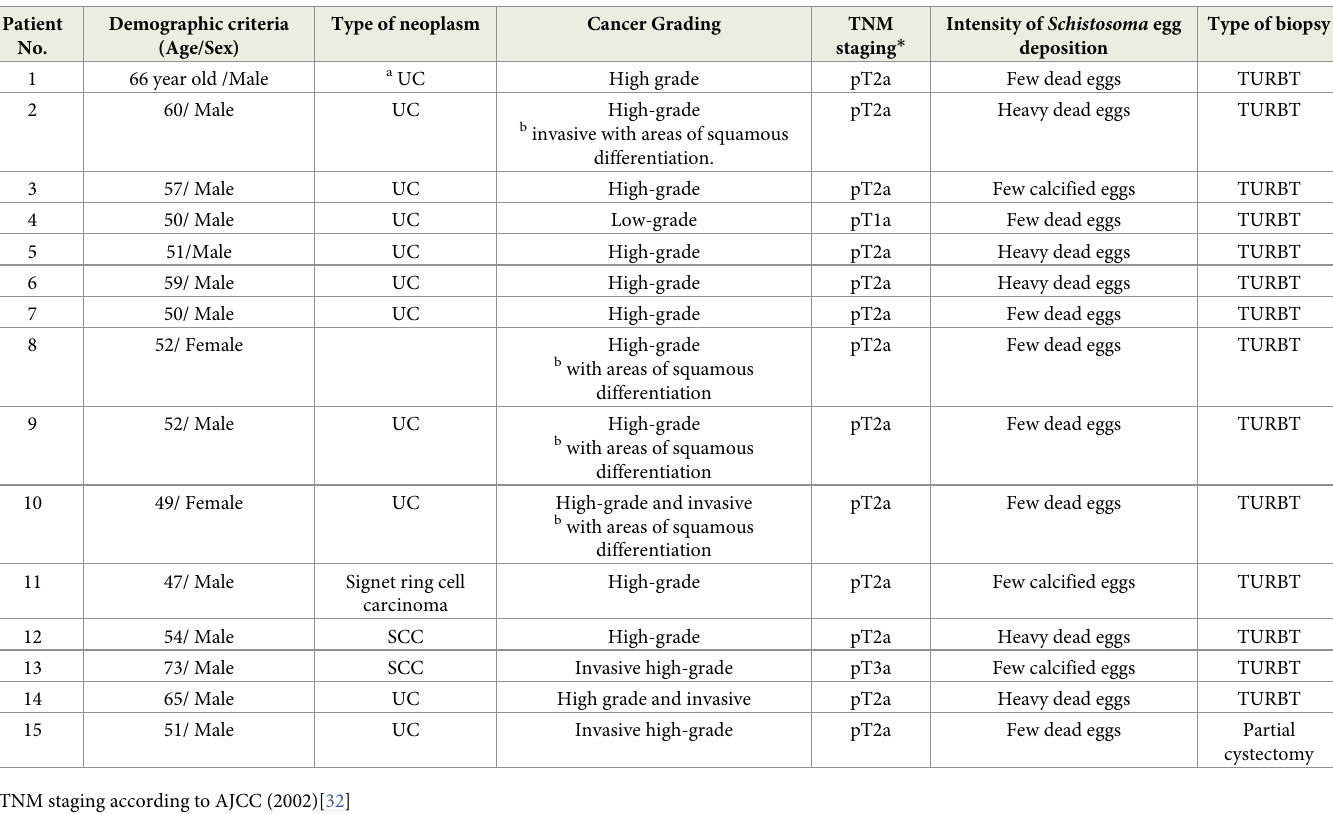
mixed UC with Squamous cell